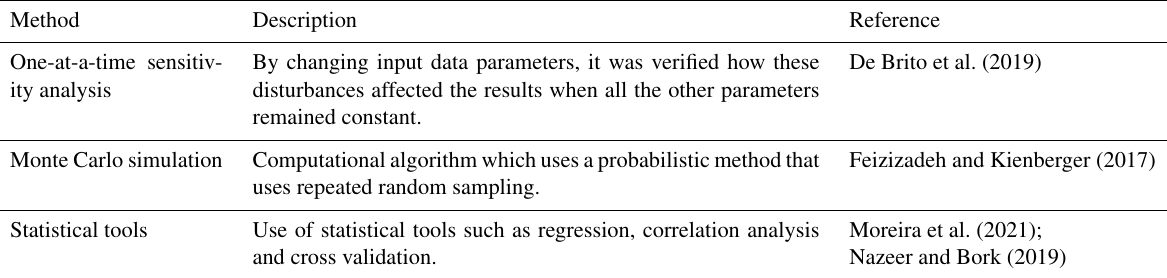
Table 3. Characteristics of the main methods for uncertainty and sensitivity analysis used for building